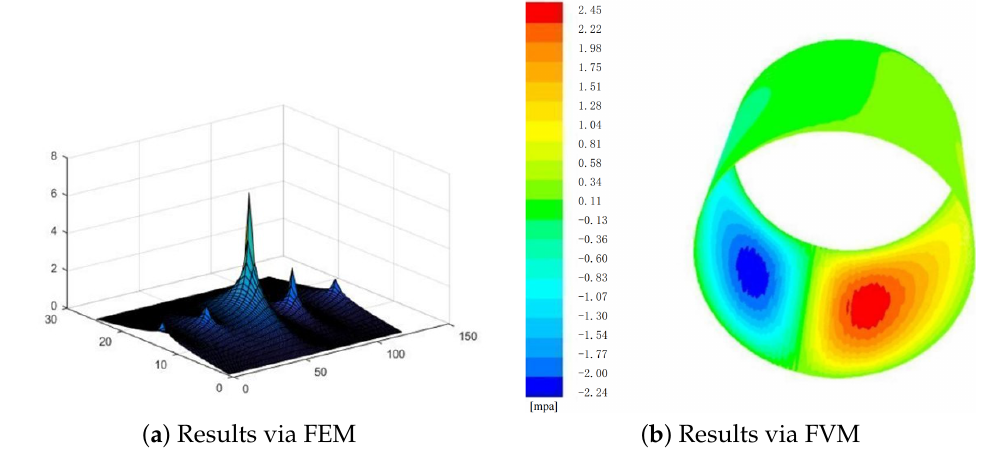
Figure 2. Pressure distribution of oil film on the journal hydrostatic bearing: oil pressure (MPa).